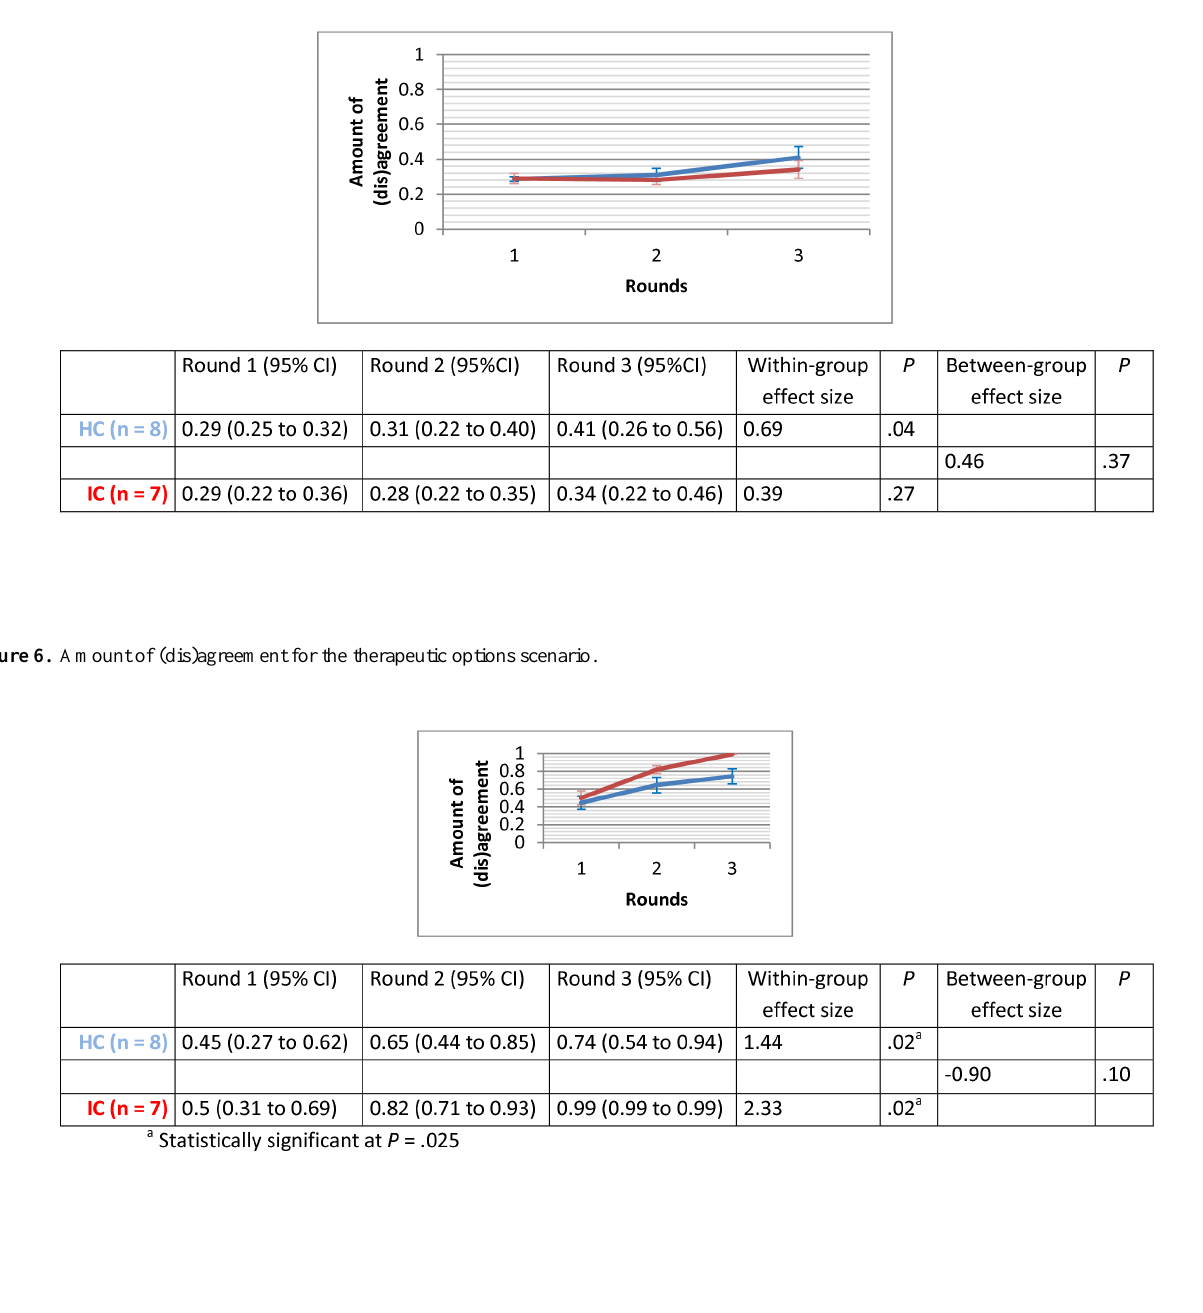
Figure 5. Amount of (dis)agreement for the medical imaging scenario.